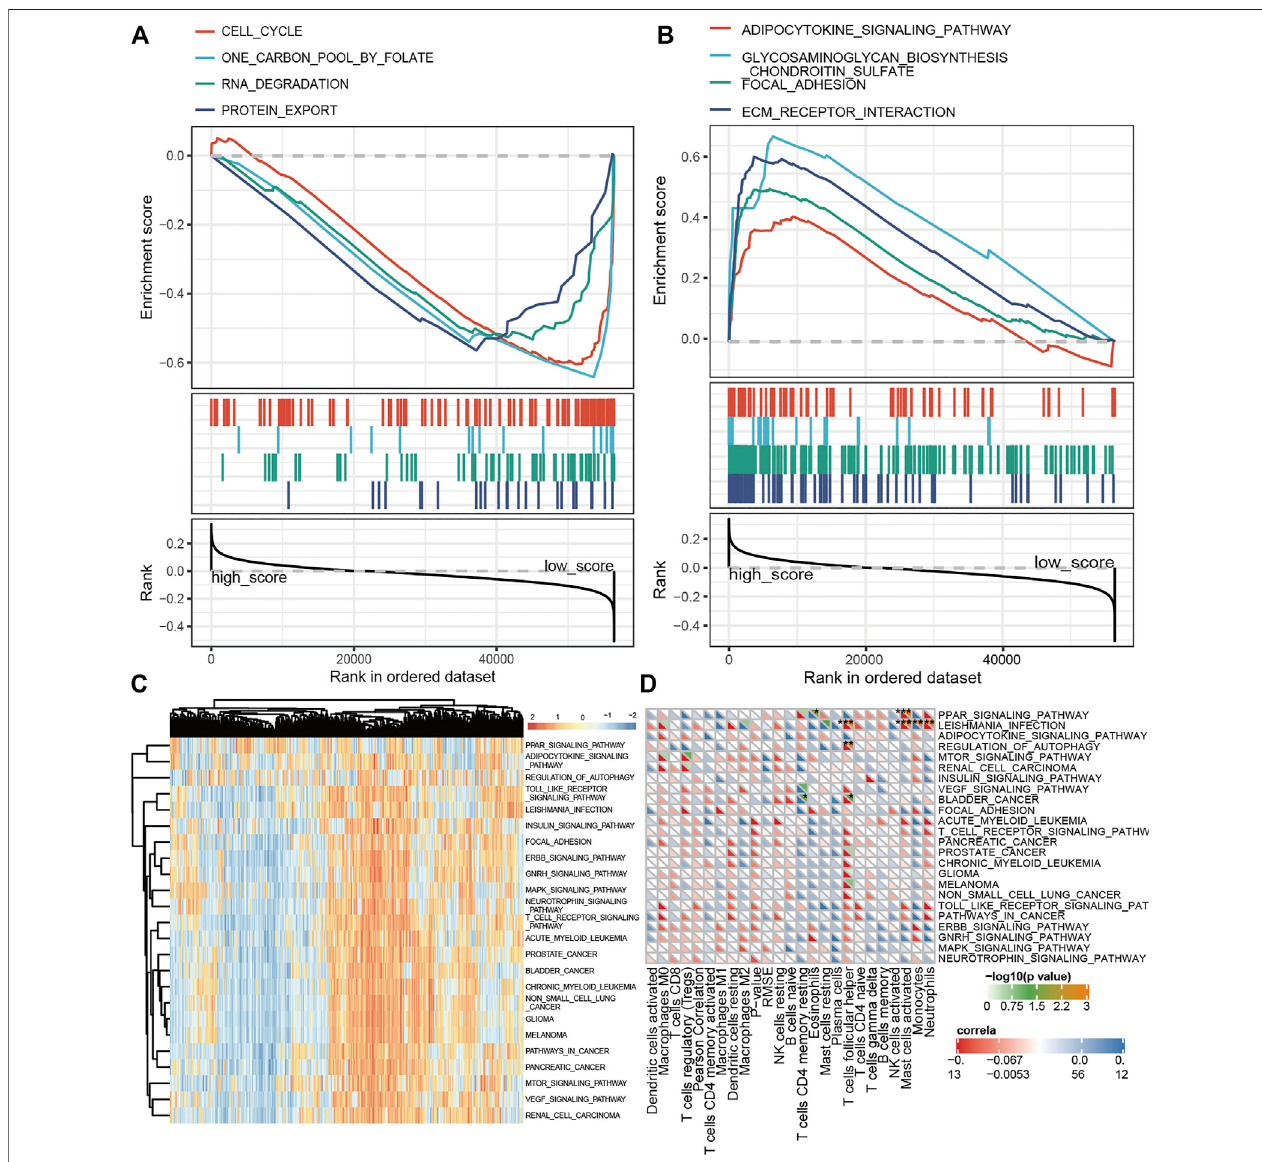
FIGURE 9 | KEGG, GO analysis of FRGs in the E-FRG model. (A) KEGG analysis showing main pathways related to ferroptosis. (B – D) GO analysis showing signi fi cant GO terms related to FRGs. (B) FRGs related to biological processes. (C) FRGs related to cell components. (D) FRGs related to molecular